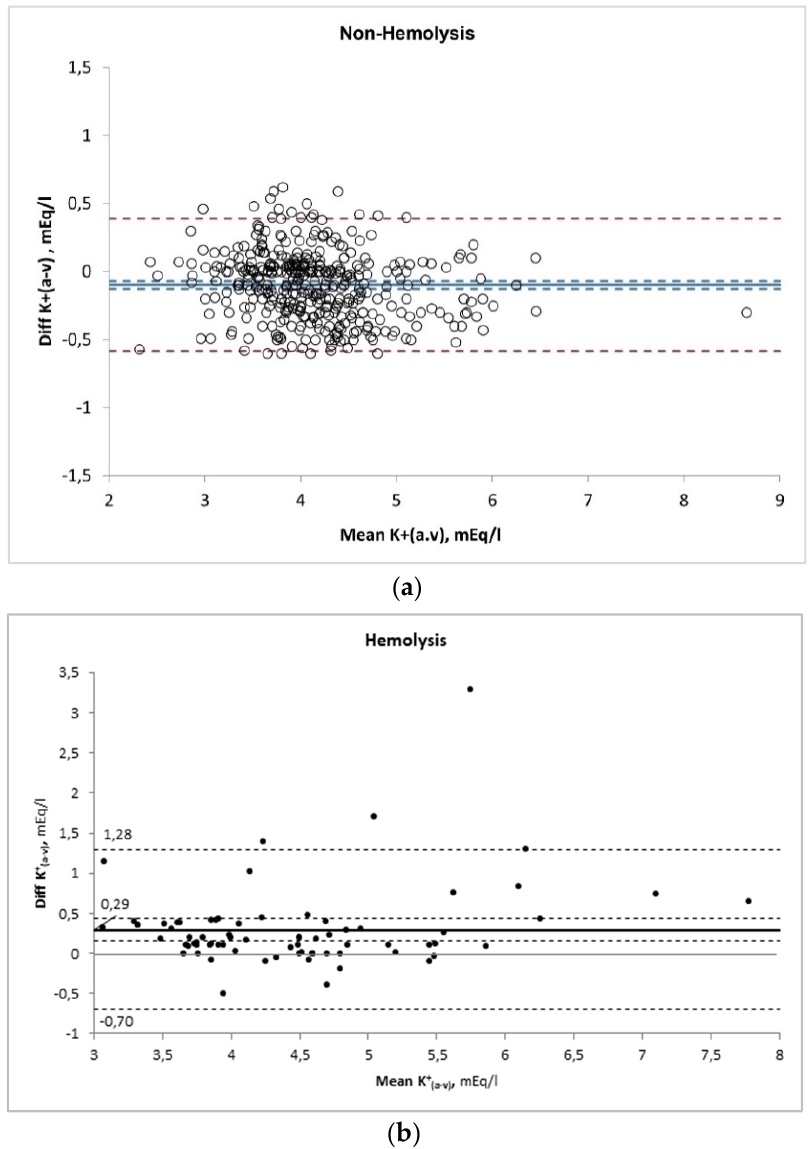
Figure 3. Bland–Altman Analysis. Plot ( a ) non-hemolyzed samples; plot ( b ) hemolyzed samples.